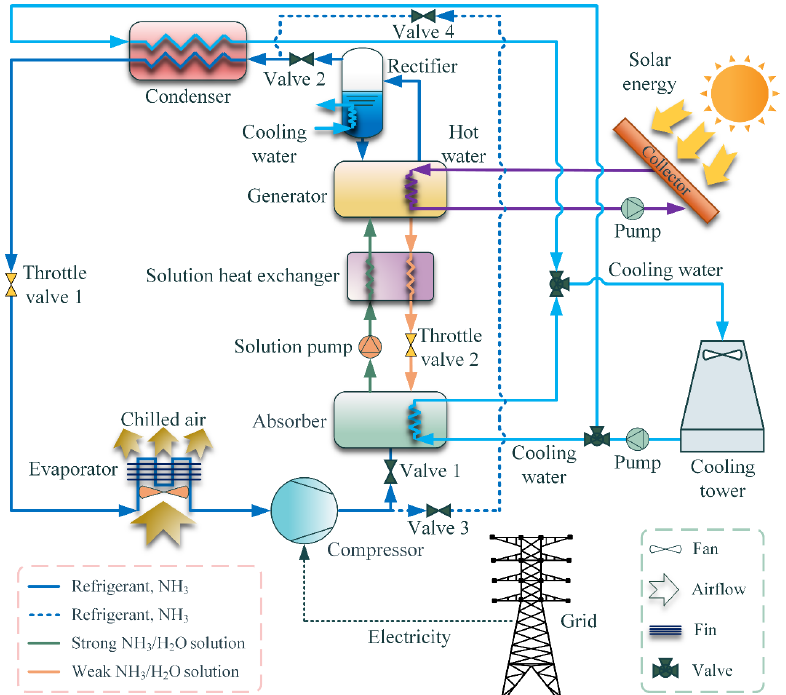
Figure 1. Schematic diagram of solar-assisted two-stage cycle with thermal and mechanical compression processes. The schematic diagram of a solar-assisted hybrid cooling system with the cascade condensation process can be seen in Figure 2. The corresponding system is made up of